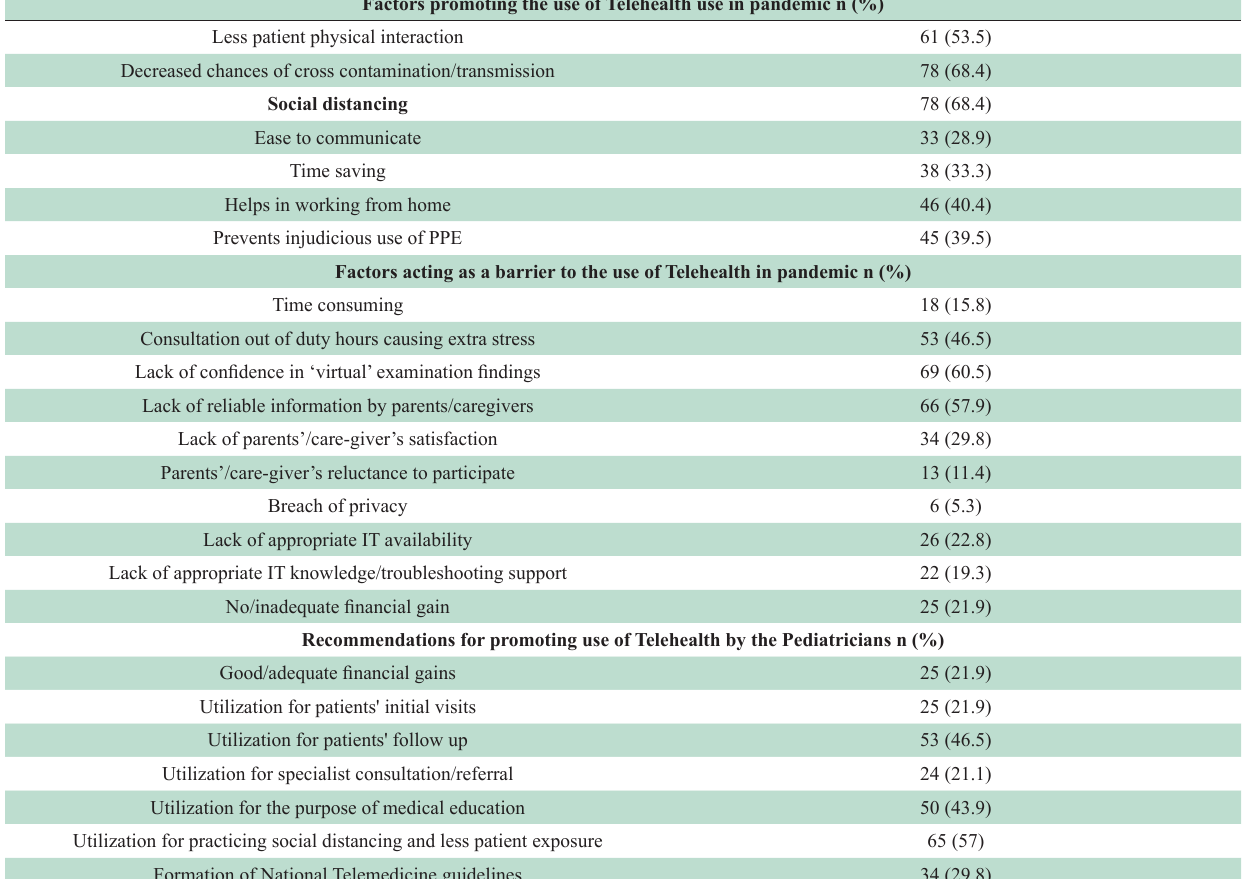
Table-IV: Factors promoting and preventing Telehealth use among pediatricians